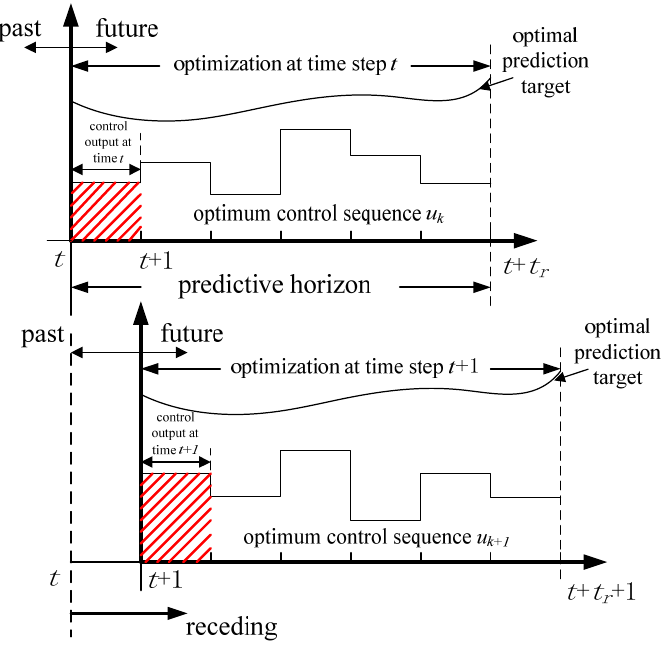
Figure 5. Prediction optimization principle of